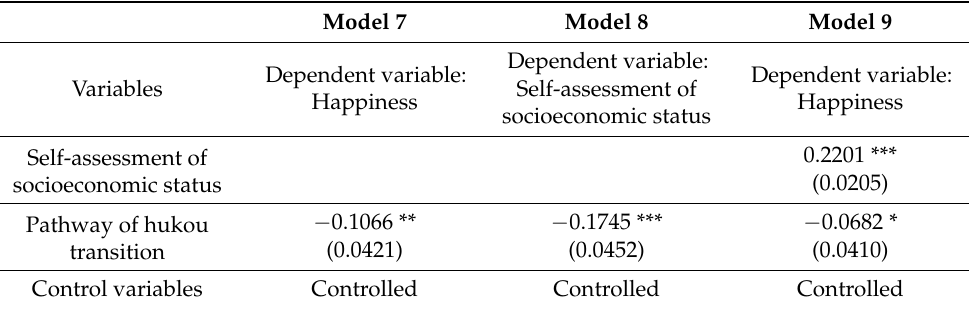
Table 7. Estimation of socioeconomic status